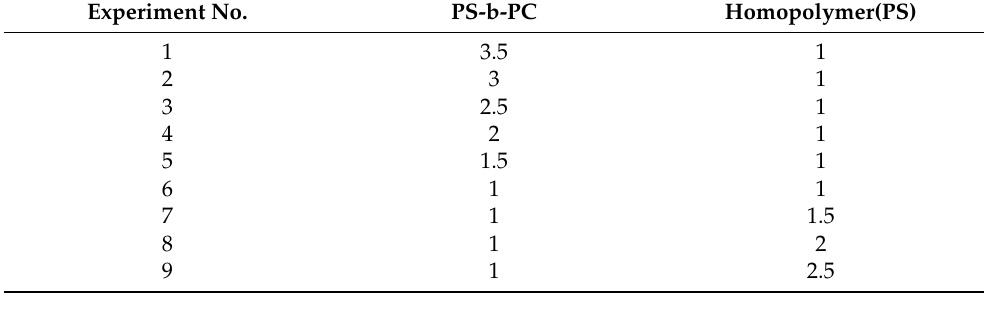
Table 1. The experiment with different ratios. Experiment No.